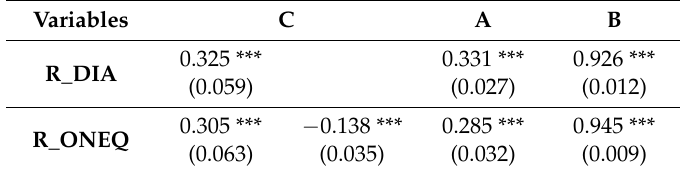
Table 21. Diagonal BEKK for US Market ETF returns (During GFC) (1 November 2007 to 31 March